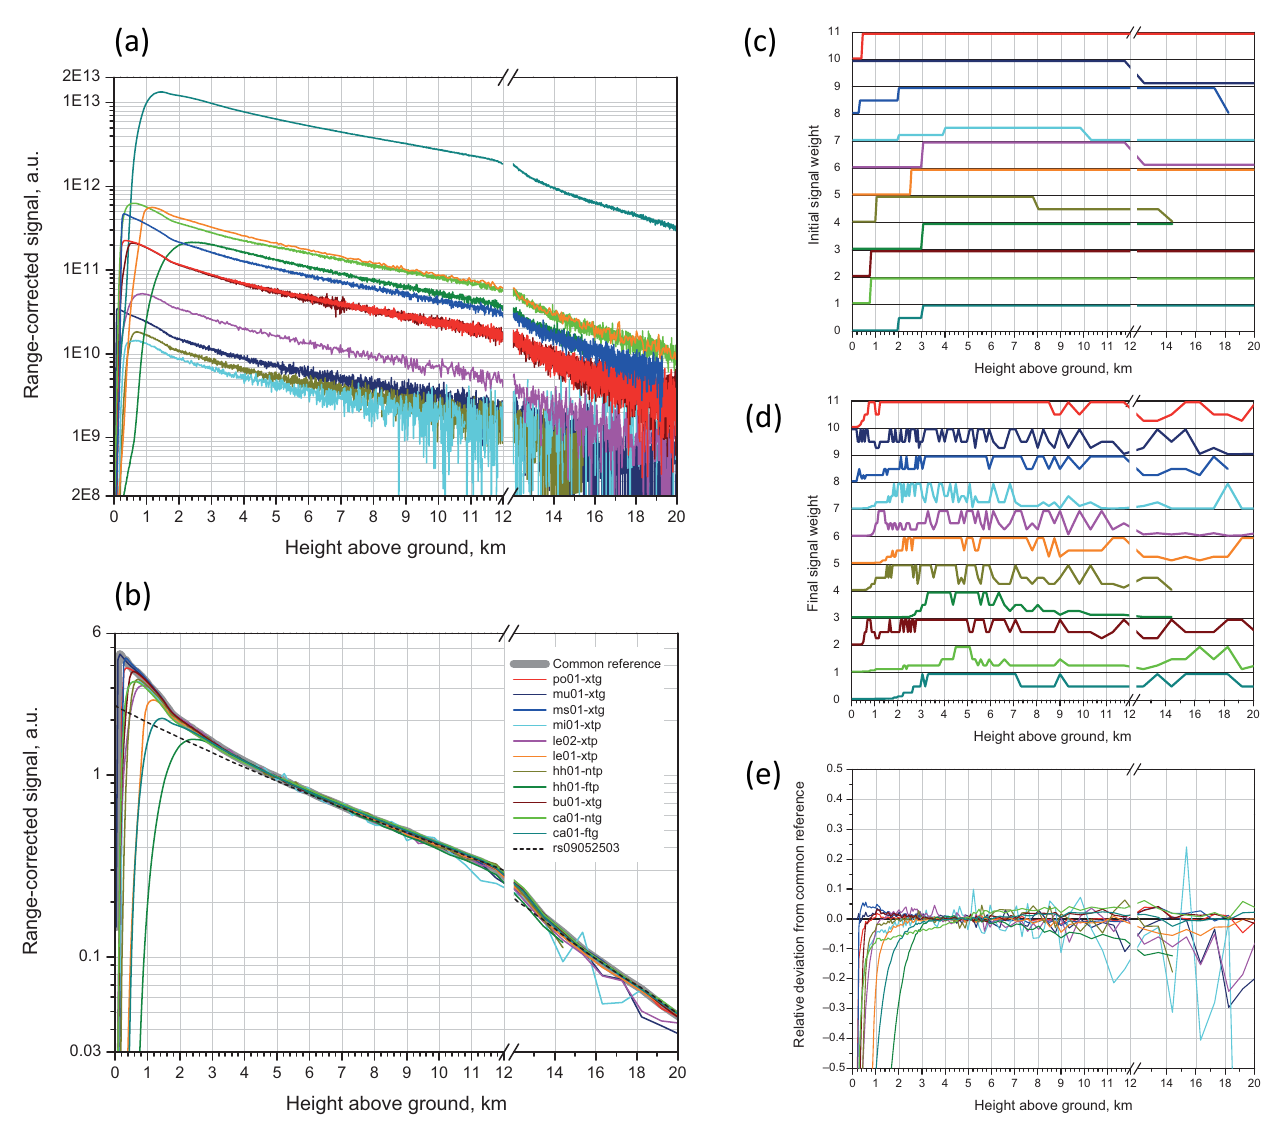
Figure 2. Illustration of signal processing for comparison purposes. The measurement was taken during EARLI09 on 25 May 2009, 21:00– 23:00UTC. (a) Range-corrected signals at 387nm with individual range resolutions (3.75 to 60m). (b) Range-corrected lidar signals at 387nm binned to common height resolution (60m) and to common height levels, progressively smoothed (60m up to 3km, 120m from 3–6km, 240m from 6–9km, 480m from 9–12km, 960m above), and normalized between 3.5 and 6.5km. The thick gray line represents the common reference. A pure molecular signal at 387nm calculated from radiosonde data (rs09052503) is fitted to the common reference at 10.3km (shown below 12km) and, additionally, at 15.3km (shown above 12km). (c) Initial weights assigned to the signals for calculation of a weighted mean signal. (d) Final weights assigned to the signals for calculation of the common reference. (e) Relative deviations of individual signals from the common reference. For the sake of conspicuity the weights in panels (c) and (d) are successively shifted by a value of 1 along the y